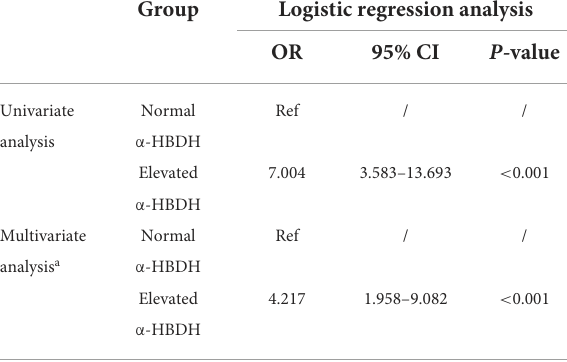
TABLE 2 The risk of elevated α -hydroxybutyrate dehydrogenase for in-hospital death during hospitalization. Group